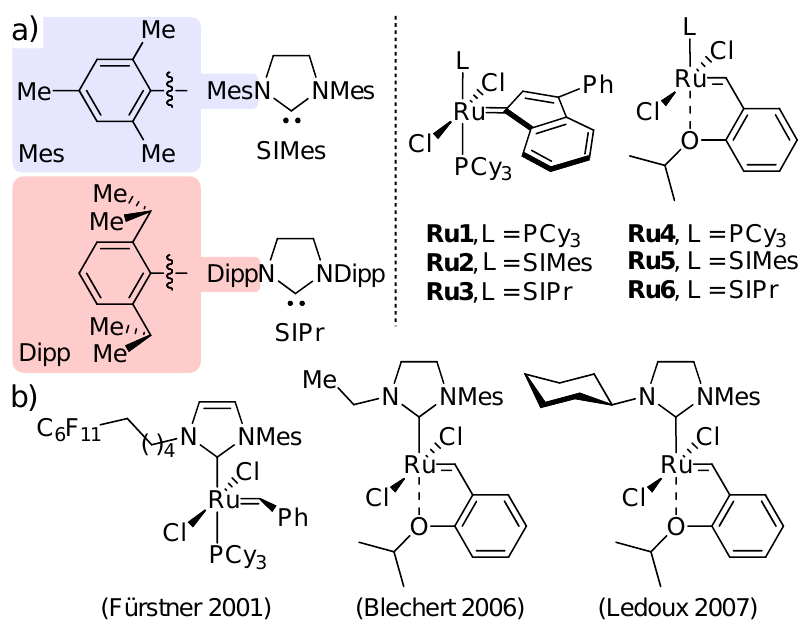
Figure 1. ( a ) Popular symmetrical N -heterocyclic carbene (NHC) ligands and selected general purpose Ru metathesis catalysts ( Ru1 – Ru6 ). ( b ) Selected representative Ru complexes containing unsymmetrical NHC ligands.